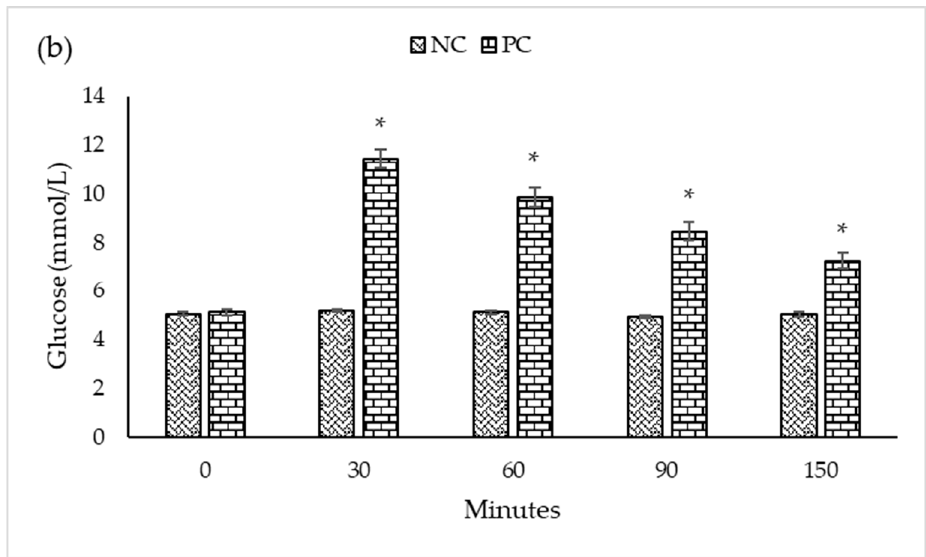
Figure 1. Fasting blood glucose level in mice groups ( a ) and a relative glucose level of negative and positive control groups until 150 min ( b ). The error bar shows the standard error of the mean. The value of the positive (diabetes) group showed a statistically significant difference (Tukey HSD; p < 0.05) compared to the negative control group in all-time points, except for 0 min. NC: negative control; PC: positive control; MET: metformin; ACR: acarbose; AEE: Abelmoschus esculentus pod extract. * denoted statistically significant at p < 0.05 between NC and PC. Table 1. Effects of therapeutic doses of different drugs either alone or in combination in mice model.